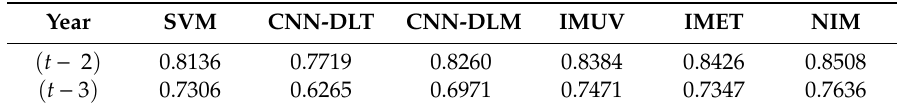
Table 5. The out-of-sample forecasting area under the curve (AUC) scores of each model with the energy training data set of the year ( t − 2 ) and ( t − 3 ) .